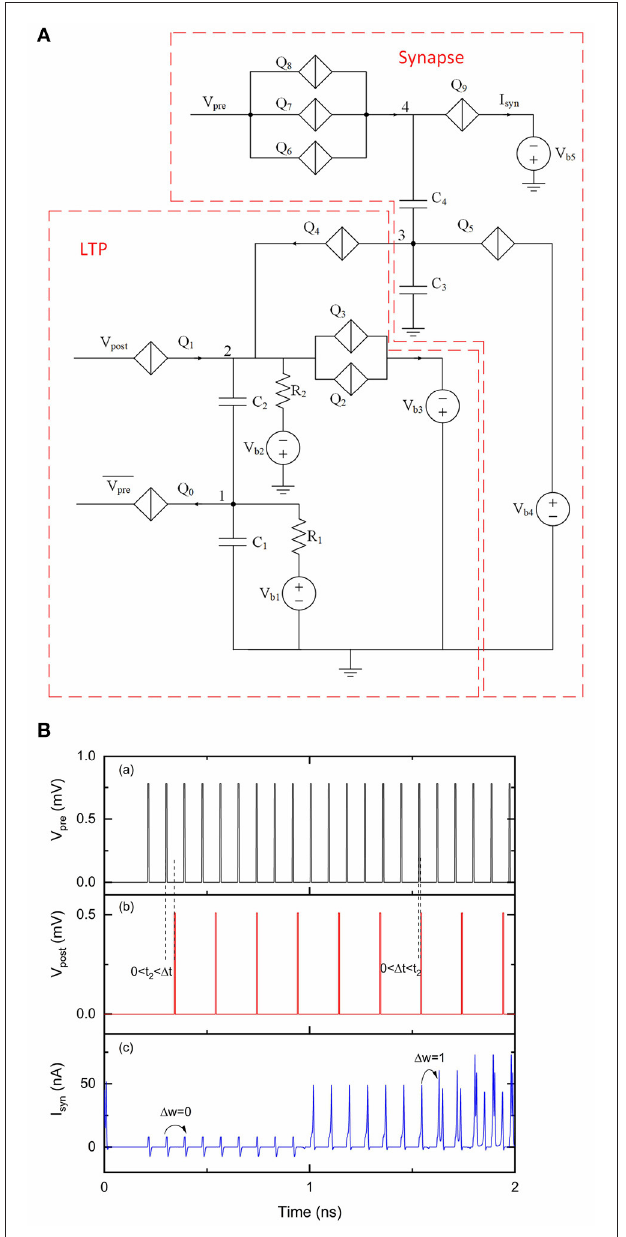
sequential current pulses at I syn can be increased when the timings of pulses from V pre and V post trigger an LTP learning event. V pre was 0.78 mV and V pre was 0.54 mV. V post was 0.51 mV. The critical voltage values used for Q 0 – Q 9 were 0.4, 0.5, 1, 1, 0.58, 2, 1.04, 1.02, 1, and 0.28 mV, respectively. C 1 , C 2 , C 3 , and C 4 were 9 fF, 1 fF, 9.2 fF and 2 fF, respectively. V b1 , V b2 , V b3 , V b4 and V b5 were 0.05, 0.2, 1.1, 1.01, and 0.6 mV, respectively. R 1 and R 2 were 10 k (cid:127) . (A) Circuit schematic. (B) Simulation results. (a) Input signal V pre . (b) Input signal V post . (c) Output signal I syn .